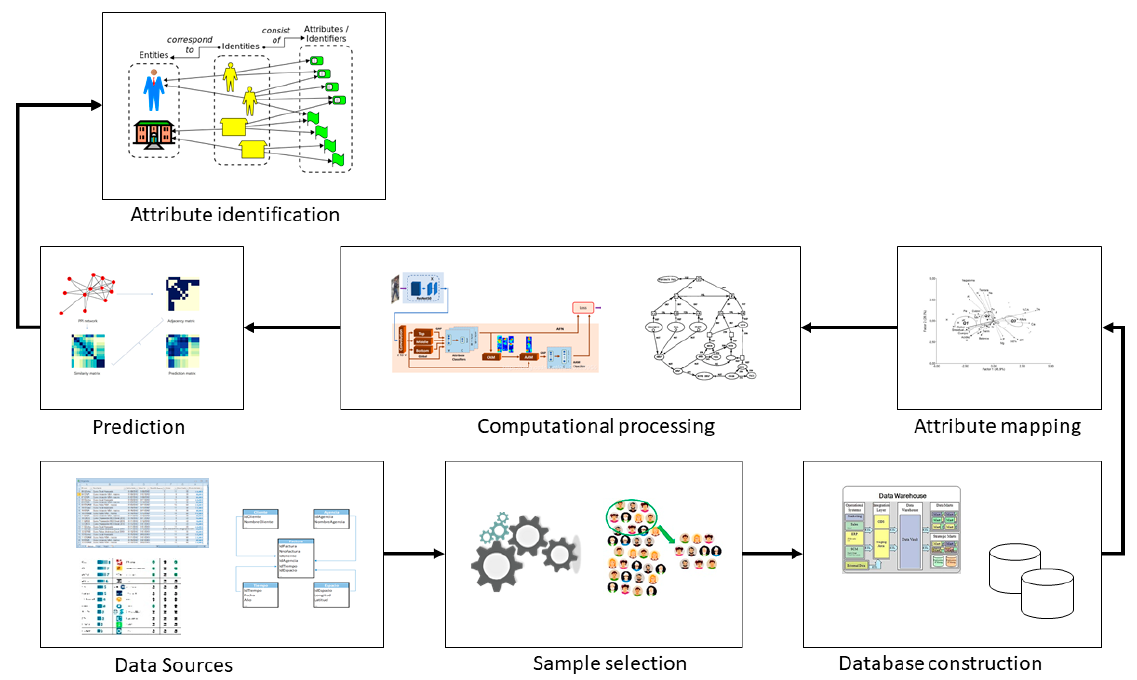
Figure 1. Methodology of a model for the identification of academic performance.